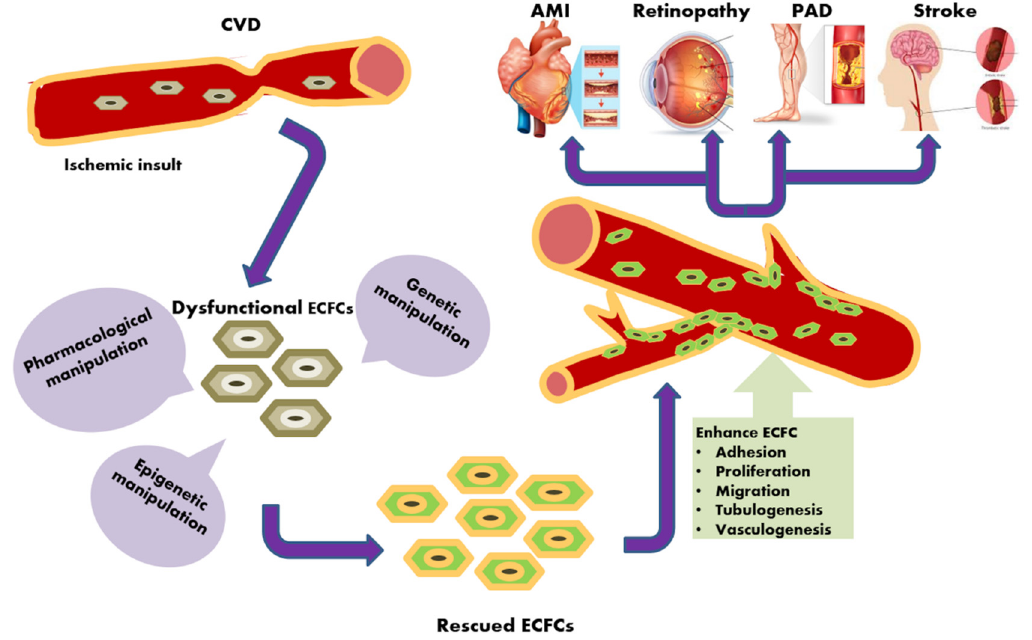
Figure 1. Manipulating dysfunctional endothelial colony-forming cells (ECFCs) to improve their regenerative potential for therapeutic angiogenesis. ECFCs isolated from the peripheral blood of individuals suffering from cardiovascular disease (CVD) present a reduced therapeutic efficacy. A number of strategies were designed to improve the regenerative potential of these ECFCs in the view of autologous cell-based therapy. These treatments include pharmacological pre-conditioning (e.g., with bioactive cues), genetic manipulation, and epigenetic activation, to improve their pro-angiogenic potential. It has been shown that ECFC manipulation remarkably improves neovascularizaiton and restores local blood flow in animal models of acute myocardial infarction (AMI), ischemic retinopathy, peripheral artery disease (PAD), and stroke.